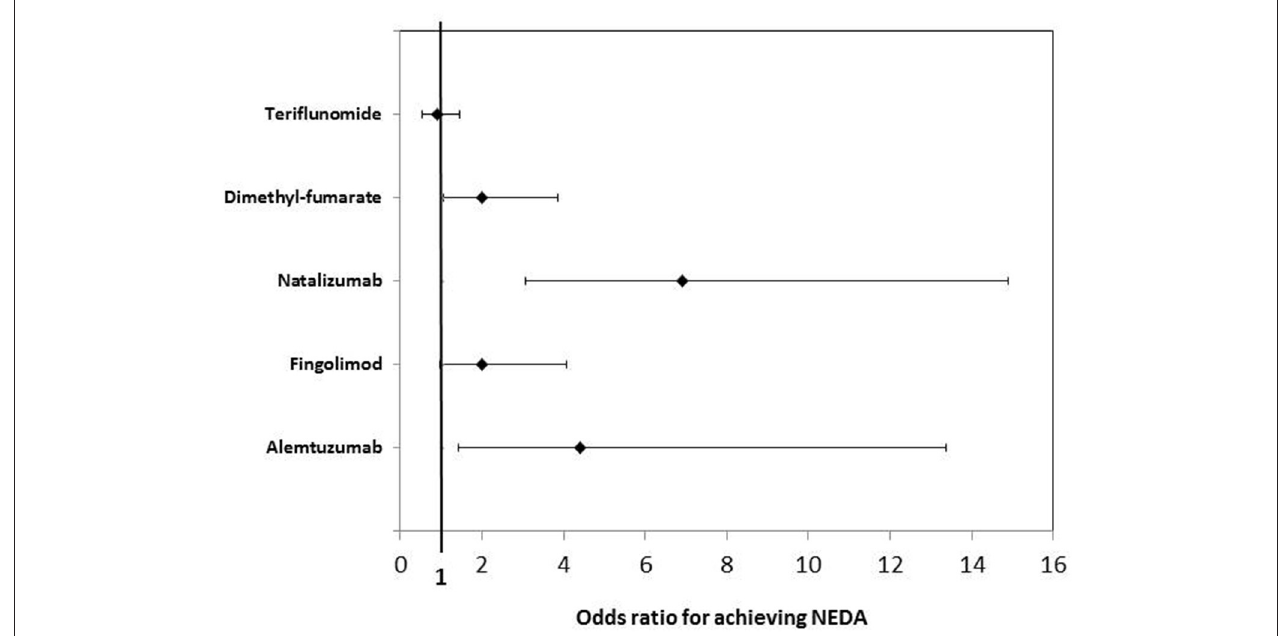
FIGURE 2 | Forest plot of odds ratio for reaching NEDA at year 1 compared to the injectables (interferon and glatiramer acetate).